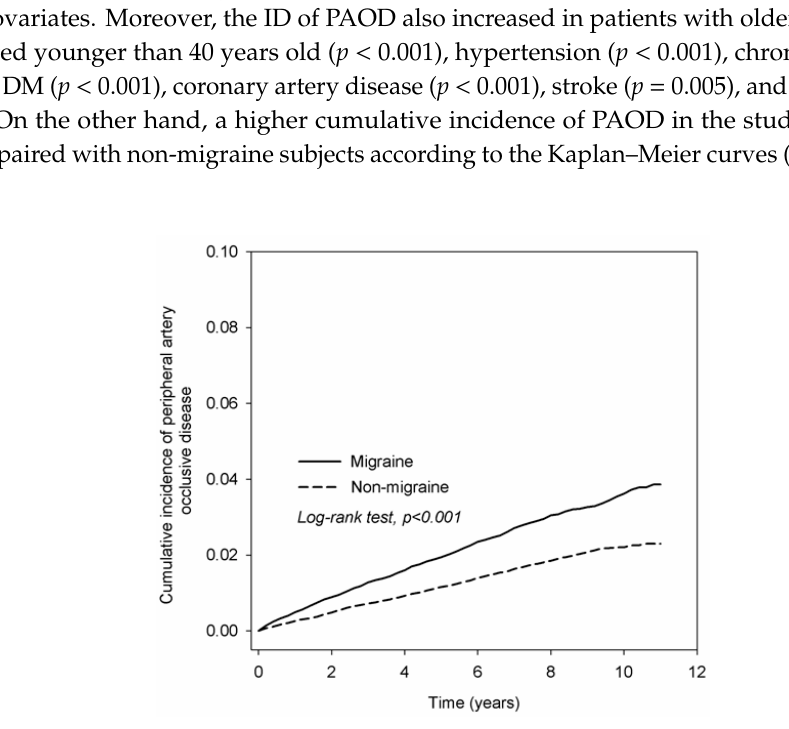
Table 3. Subgroup analysis of risk of peripheral artery occlusive disease between migraine and non-migraine group.